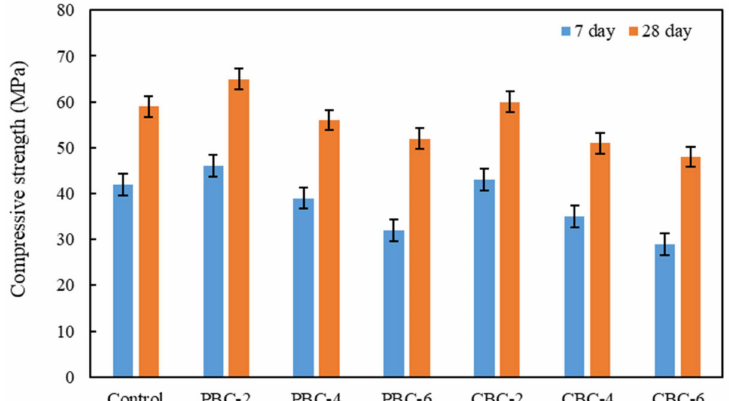
Figure 7. Results of the compressive strengths of the mixtures at 7 days and 28 days.